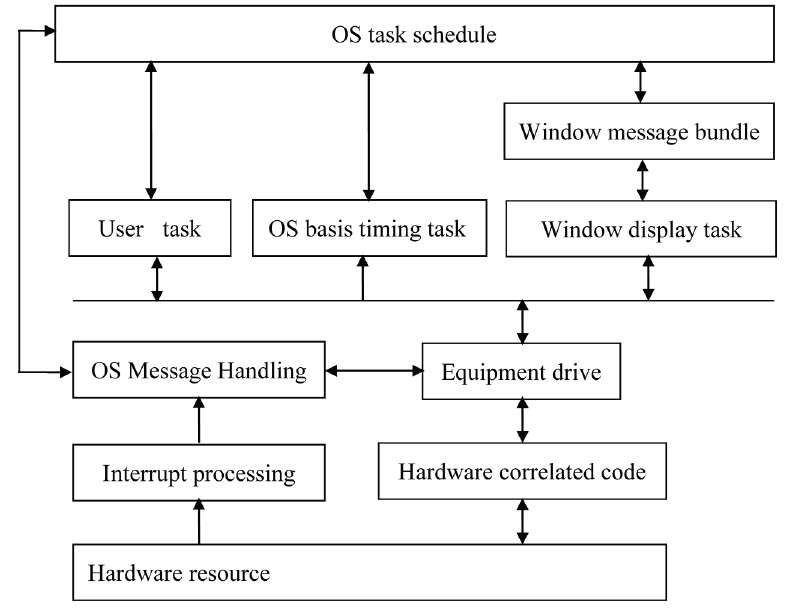
Figure 3. The software structure of